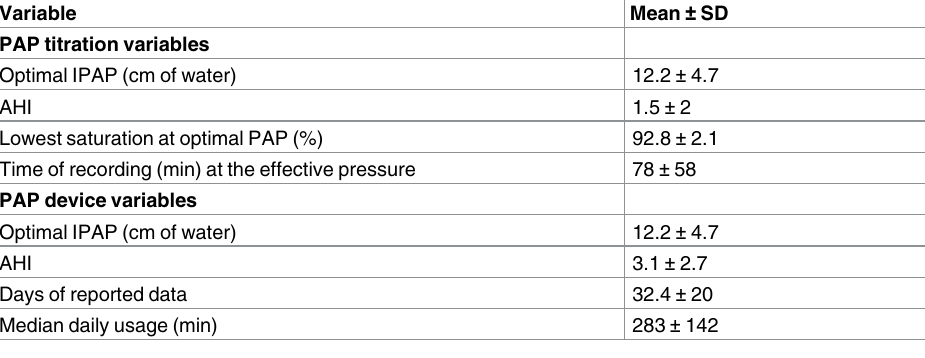
Table 2. Descriptive statistics for PSG and PAP device data (n =